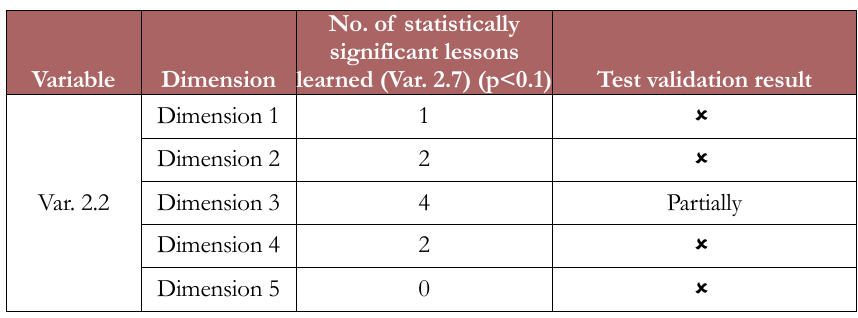
Table 5. Hypothesis 14 validation